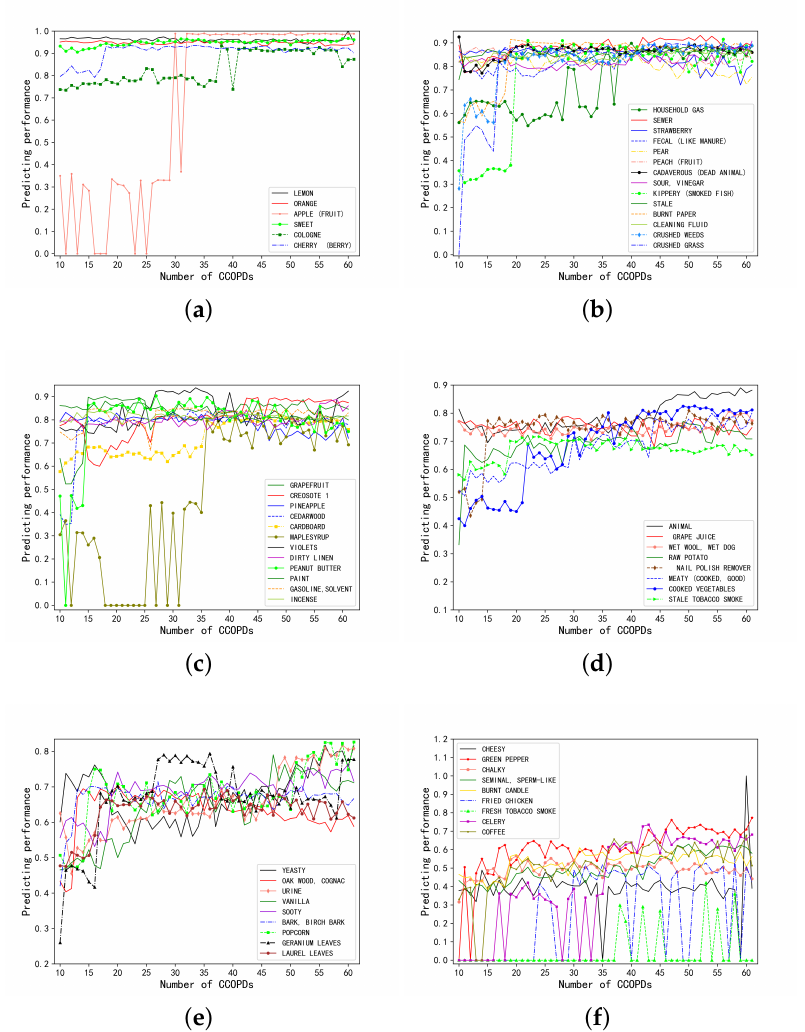
Figure 11. The relationship between the predicting performance of some predictable and unpredictable odor perception descriptors and the number of clustering centers K under the optimal configuration. ( a – c ) The results of the predictable odor perception descriptors or the predictable NPOPDs, while ( d – f ) are for the unpredictable odor perception descriptors or the unpredictable POPDs. ( a ) The relationship between the predicting performance of the predictable odor perception descriptors and the number of cluster centers. When the number of clustering-center is 41, the predicting performances of these predictable odor perception descriptors are between 0.9 and 1. ( b ) The relationship between the predicting performance of the predictable odor perception descriptors and the number of cluster centers. When the number of clustering-center is 41, the predicting performances of these predictable odor perception descriptors are between 0.85 and 0.9. ( c ) The relationship between the predicting performance of the predictable odor perception descriptors and the number of cluster centers. When the number of clustering-center is 41, the predicting performances of these predictable odor perception descriptors are between 0.8 and 0.85. ( d ) The relationship between the predicting performance of the unpredictable odor perception descriptors and the number of cluster centers. When the number of clustering-center is 41, the predicting performances of these unpredictable odor perception descriptors are between 0.7 and 0.8. ( e ) The relationship between the predicting performance of the unpredictable odor perception descriptors and the number of cluster centers. When the number of clustering-center is 41, the predicting performances of these unpredictable odor perception descriptors are between 0.6 and 0.7. ( f ) The relationship between the predicting performance of the unpredictable odor perception descriptors and the number of cluster centers. When the number of clustering-center is 41, the predicting performances of these unpredictable odor perception descriptors are below